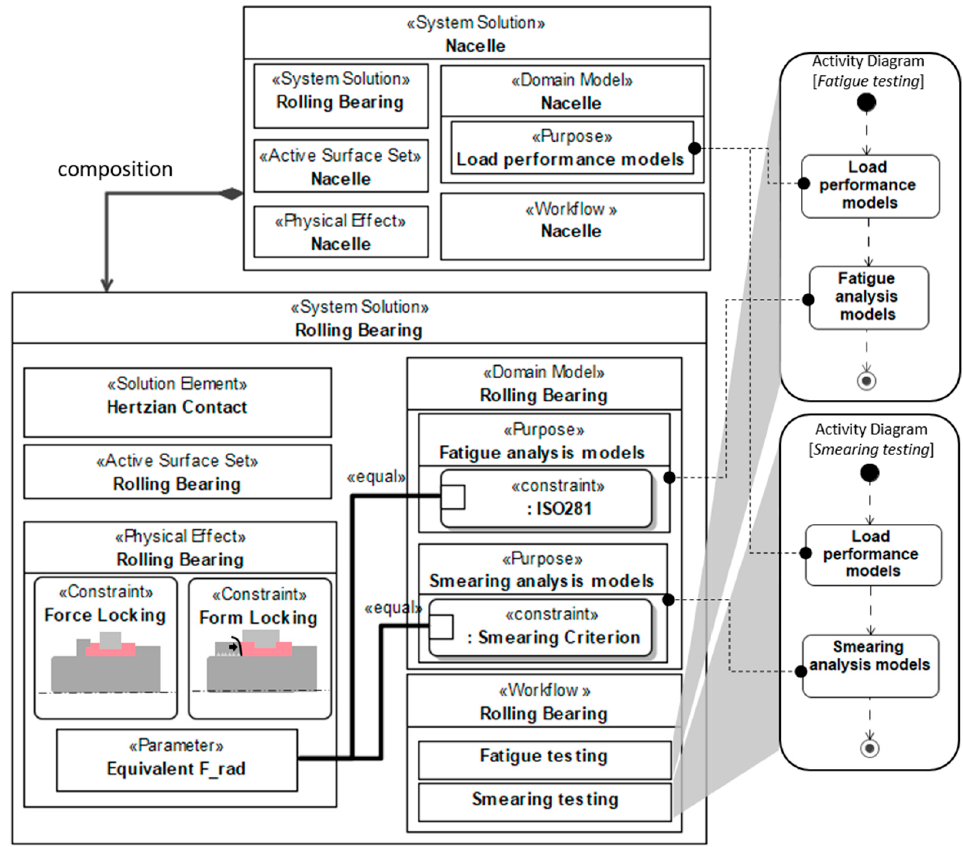
Figure 7. Virtual testing workflow in the function-oriented system architecture .